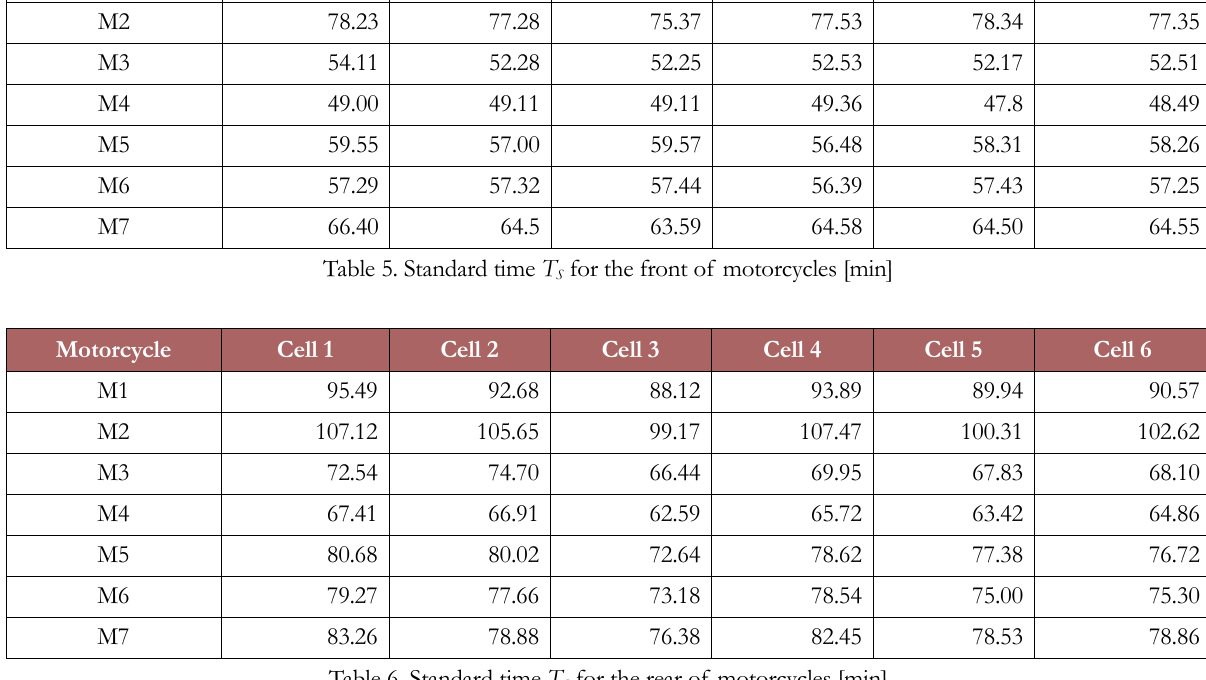
Table 6. Standard time T for the rear of motorcycles [min] S The minimization of the objective function given by Equation (19) for the assembly processes in the front and rear parts of each motorcycle model, leads to the multiple linear regression models given in Tables 7 and 8.